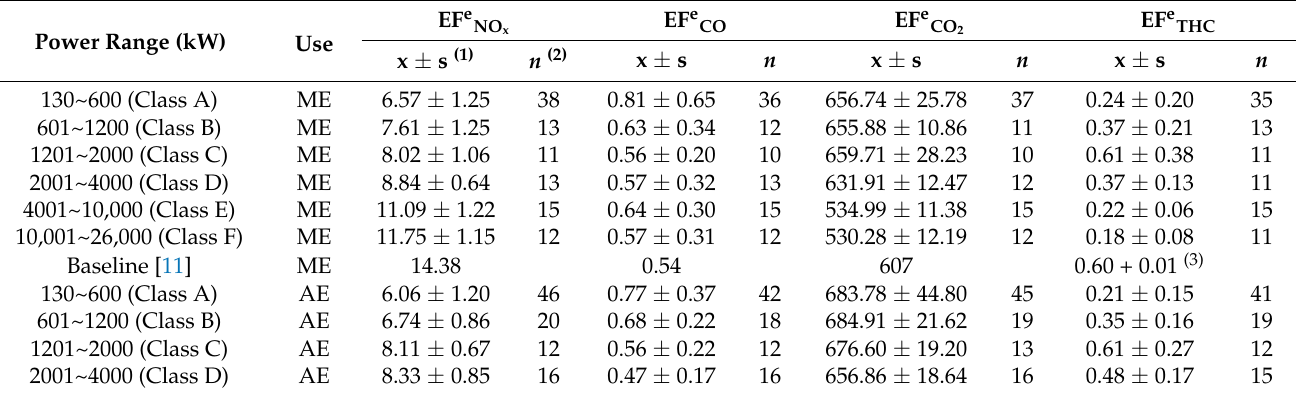
Table 3. Energy-based emission factor (g/kW